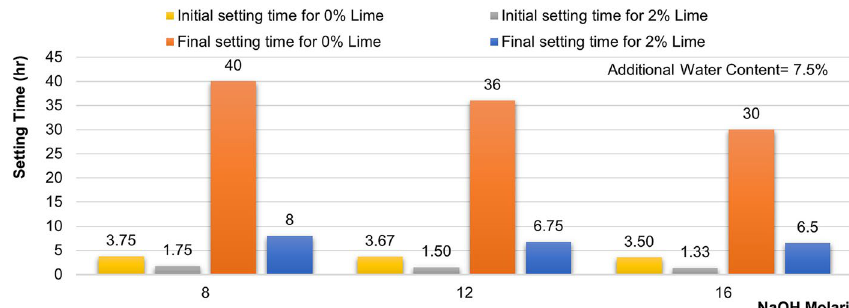
Fig. 2 The effect of NaOH molarity on the initial and final setting times for additional water content of 7.5%